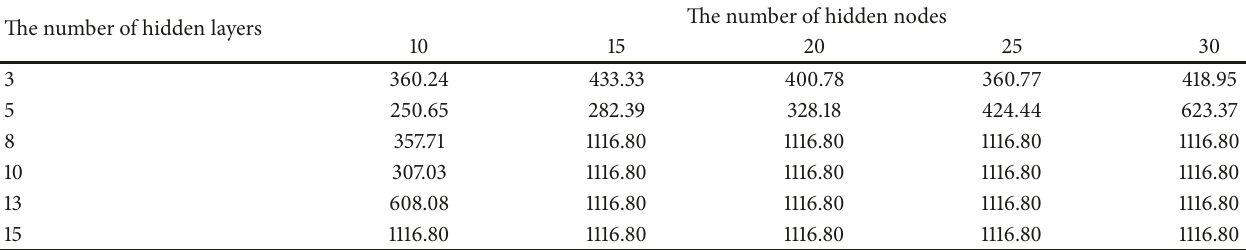
Table 1: The prediction error of MELM models with fixed network structure.